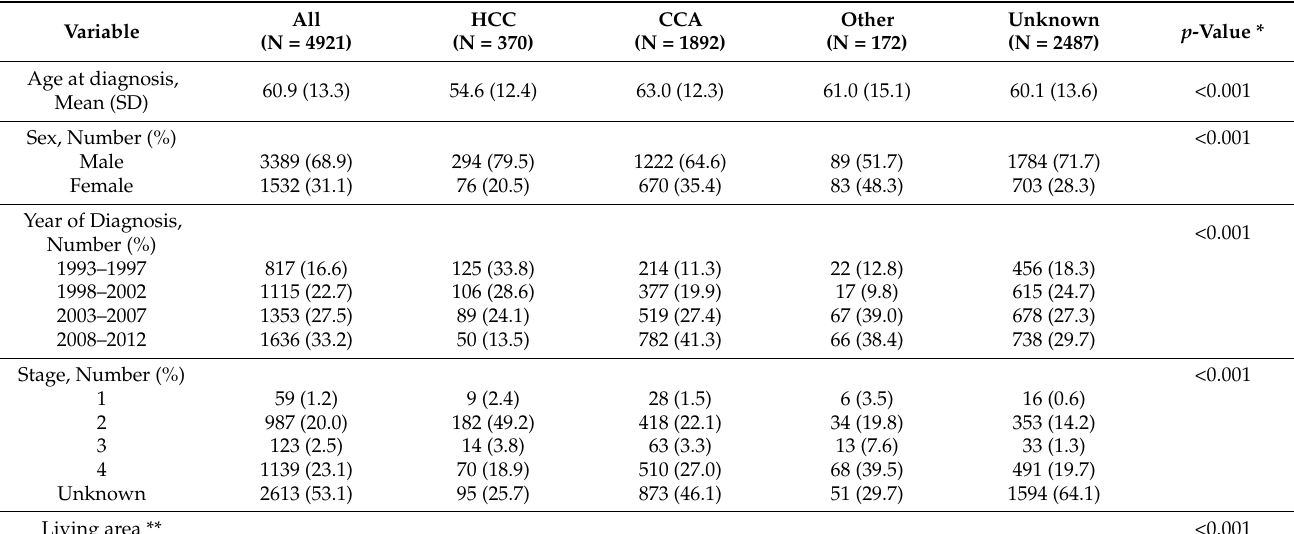
Figure A1. The proportion of HCC in 1993 by sex with a given number of imputations. The proportions stabilized after about 100 imputations, strengthening our argument that more rounds of imputations are needed especially when the percentage of missing is large, and the sample size is small. Table A1. Descriptive characteristics of liver cancer cases in Lampang,